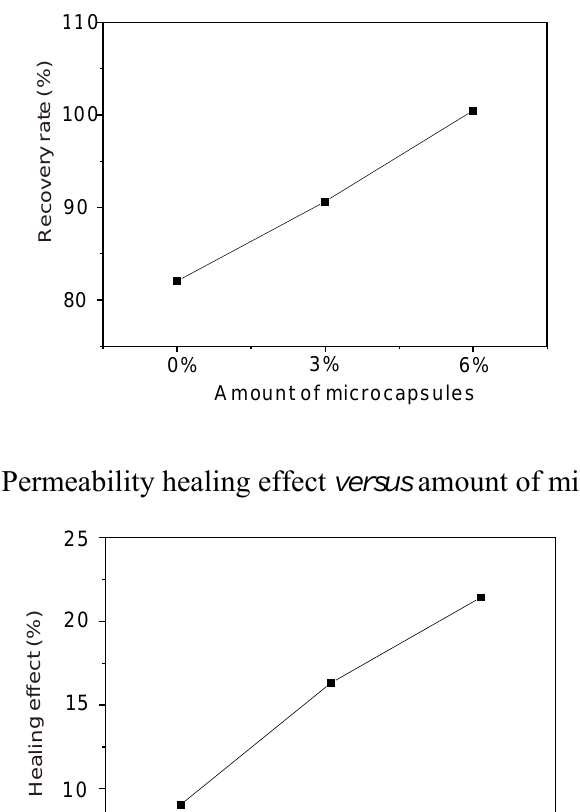
Figure 12. Permeability recovery rate versus amount of microcapsules.